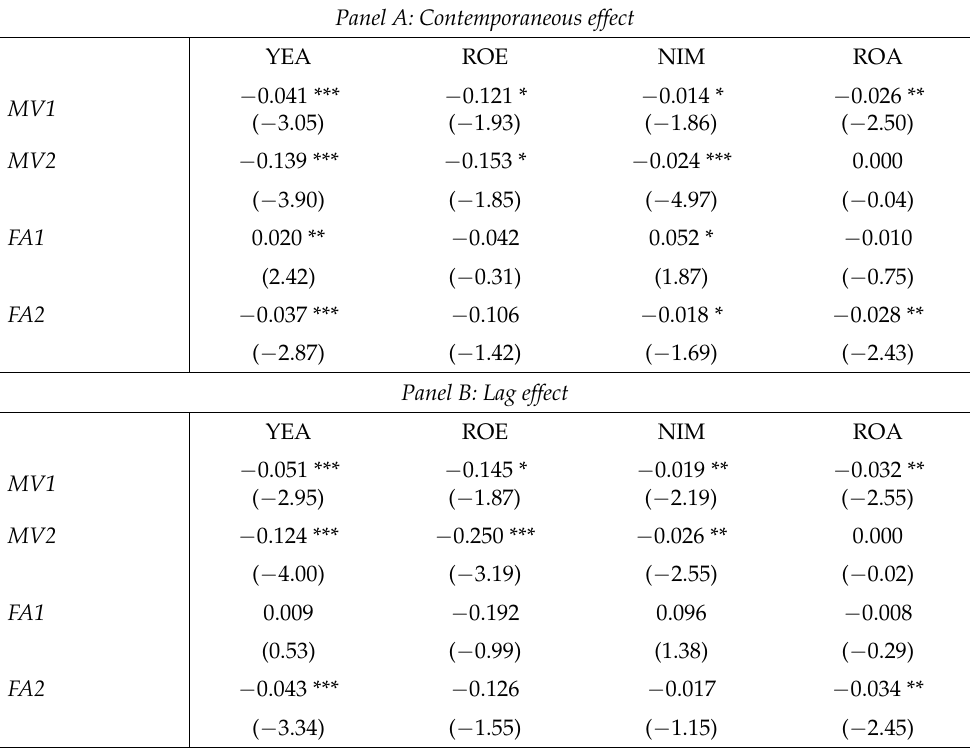
Table 7. Effect of FinTech firms on bank performance sorted by bank characteristics. Panel A: Contemporaneous effect